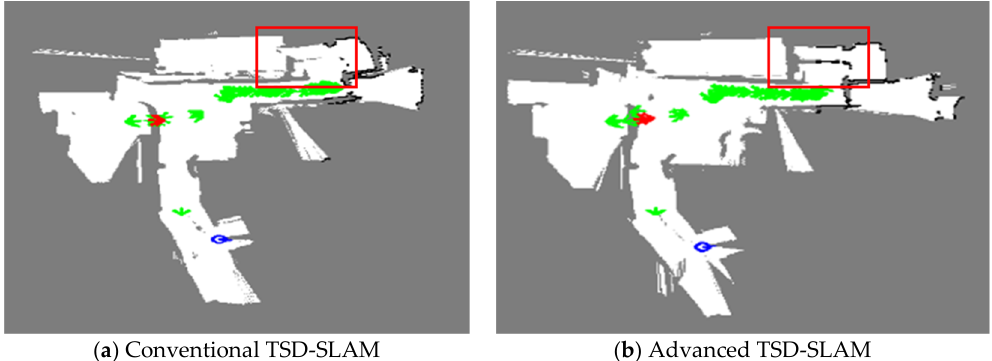
Figure 15. Comparison of the conventional TSD-SLAM and the advanced TSD-SLAM: ( a ) bent map in the red box (matching failure occurs in reactive situations); ( b ) issue resolved.